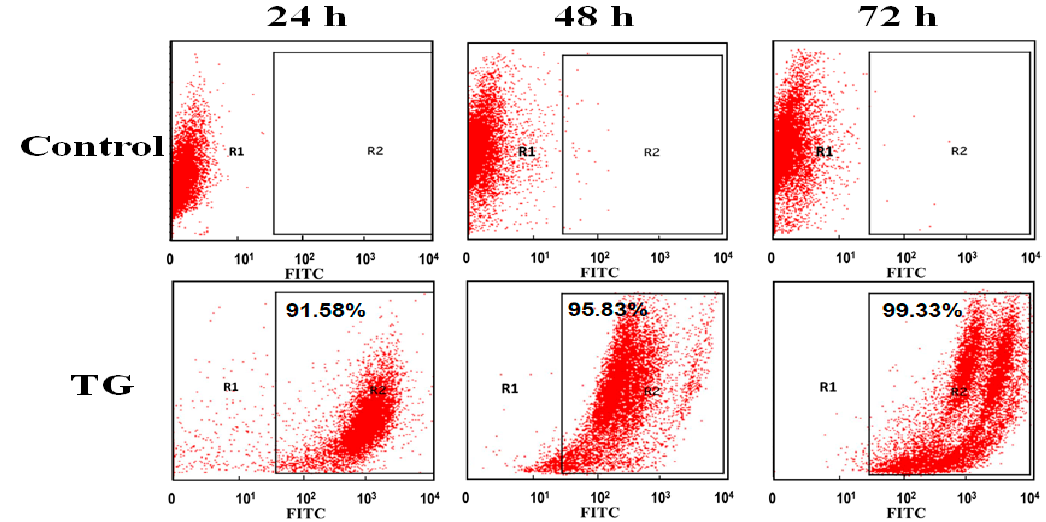
Figure 4. Flow cytometry analysis of OCM-1 cells incubated with FITC-stained TG for various time periods.